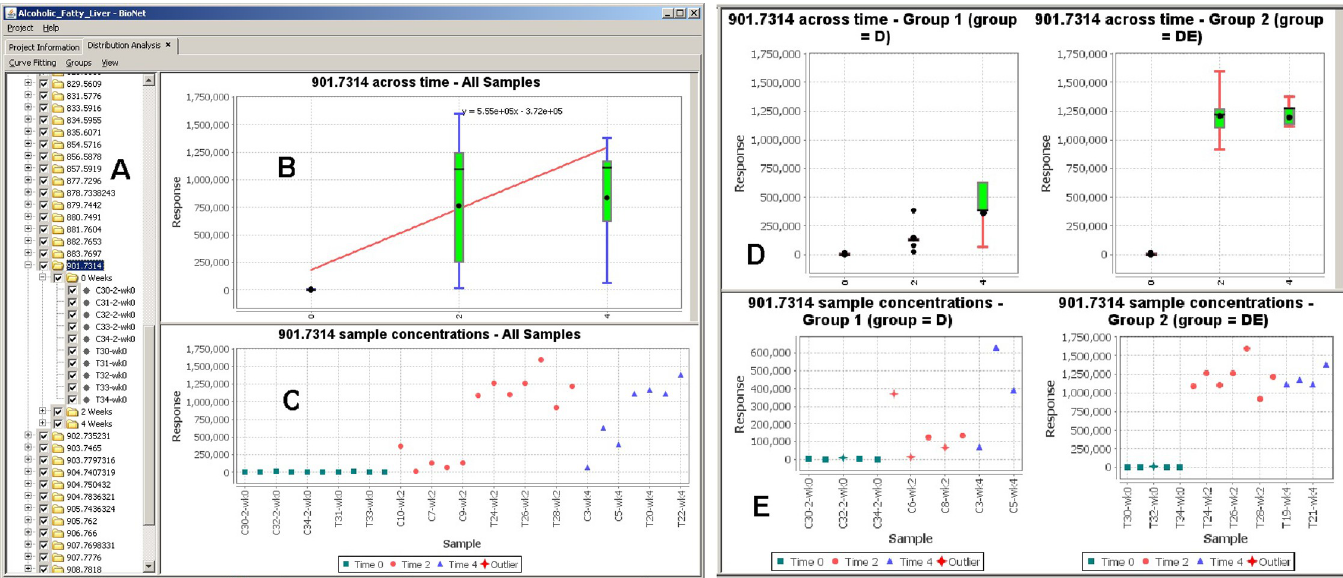
Fig 5. Comparative and distribution analysis. (A) A tree describing the molecules and their corresponding samples and time points. (B) Box plot displaying the concentration of a selected molecule across time points while applying the Robust Linear fitting. (C) Concentration distribution plot of the molecule across all samples. (D) and (E) display the same plots but for two sample groups (control and test) side-by-side for ease of comparison.